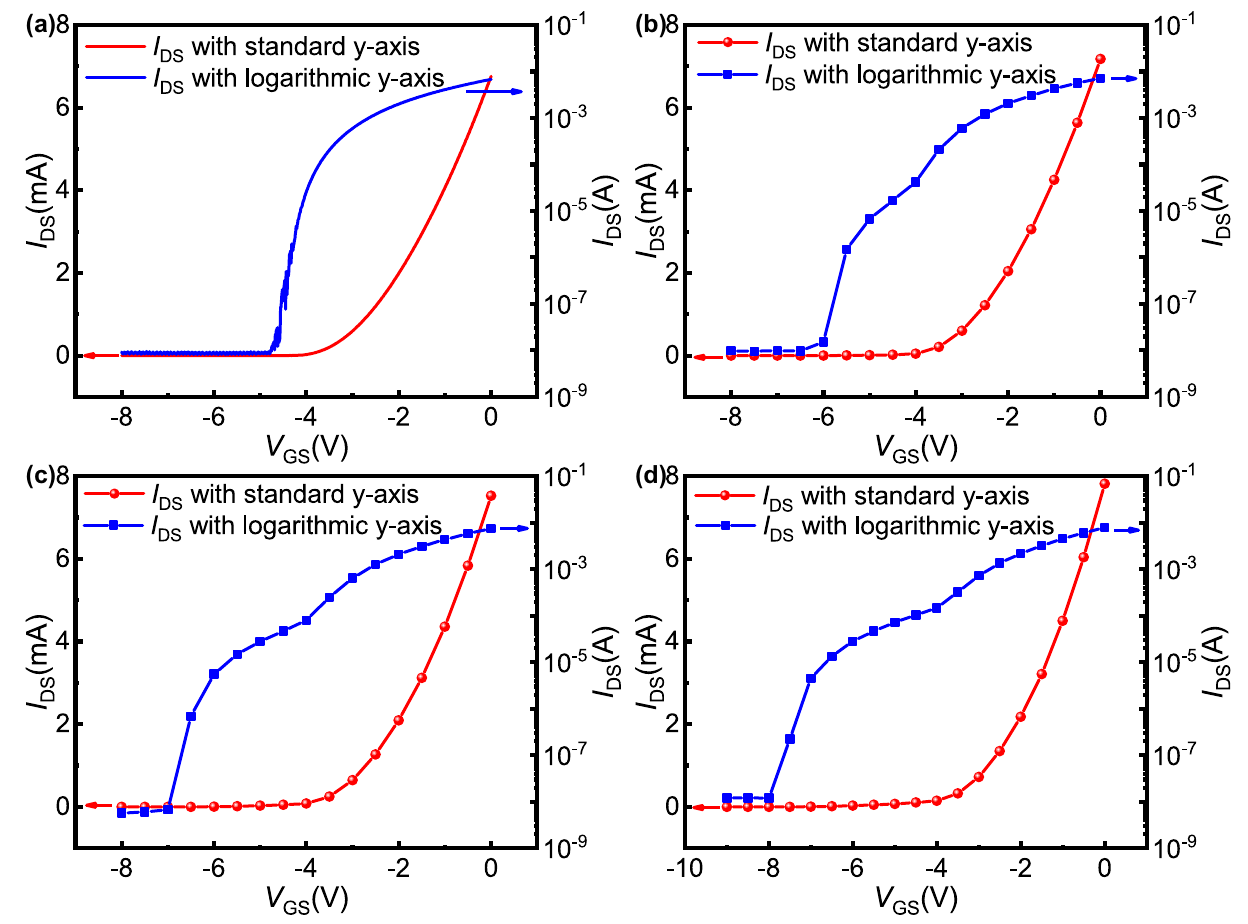
Figure 4. The measured transfer characteristics with standard y-axis and logarithmic y-axis: ( a ) sample 1, ( b ) sample 2, ( c ) sample 3, and ( d ) sample 4. The drain-source voltage is constant at 10 V during measurement. The transfer characteristics of open-gate devices are extracted from their output